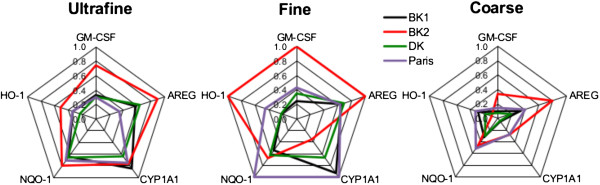
Synthesis of African and French PM effects on 16HBE cells. Data are represented in radar graphs in order to compare the effect of size fractions and the origin of the particles on mRNA expression. For each biomarker and whatever PM size and origin, the most induced condition is fixed to 1, and the other results are related to this value.